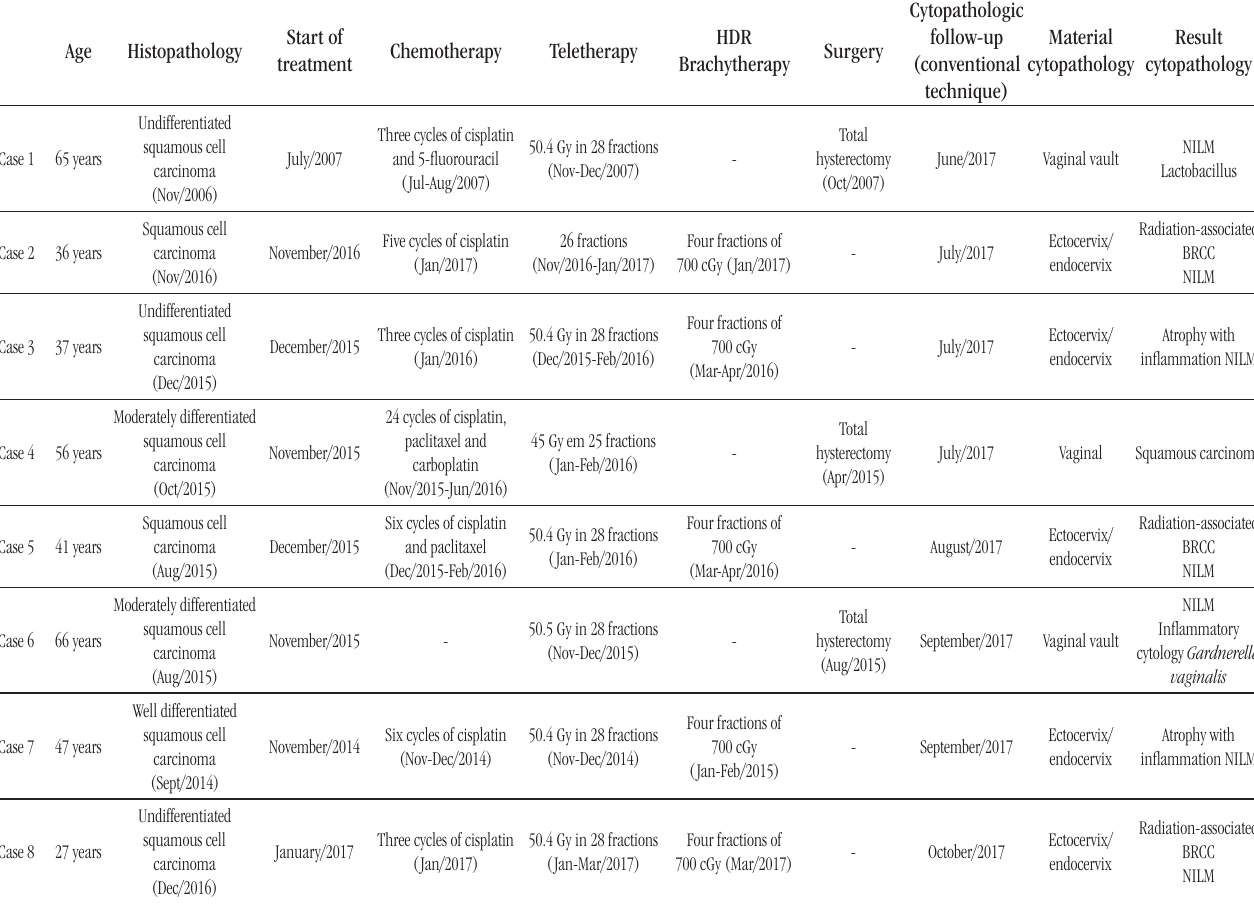
taBLE − Histopathological characteristics, treatments and results of cytopathologic follow-up of women with cervical cancer after radiotherapy and/or